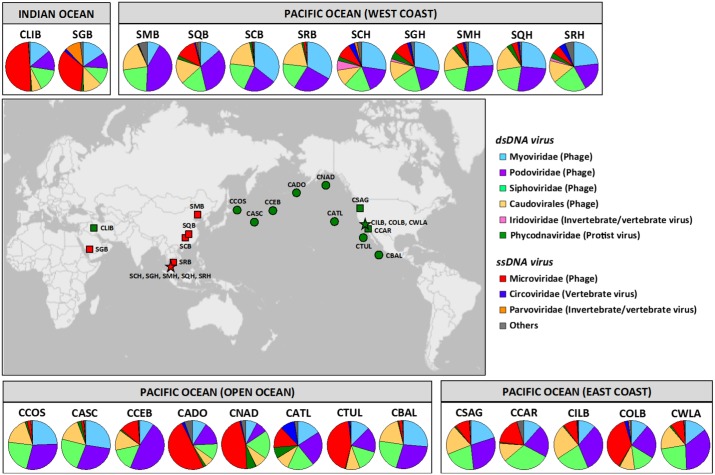
Relative distribution of viromes from ballast and harbor waters.Pie charts represent a mean relative abundance of viral families (three replicates from 24 samples). ‘Others’ are viral families whose maximum relative abundances across viromes are less than 3% (including RNA viruses). Vessels with ballast waters arriving in the Port of LA/LB are shown as a green star and the Port of Singapore as a red star. Circles and squares in the map indicate ballast waters exchanged beyond and within 200 nautical miles from nearest shoreline, respectively. ds, double-stranded; ss, single-stranded.